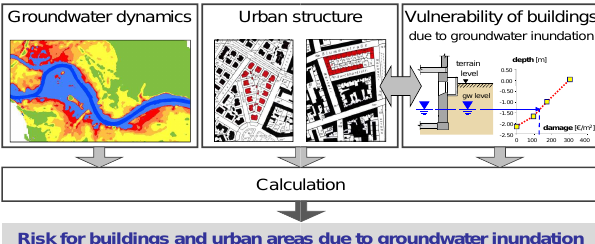
Fig. 1. General structure of the model approach